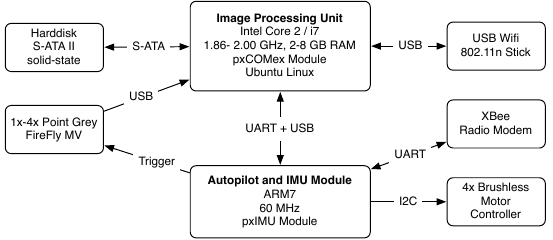
Figure 6: Onboard sensors and avionics with electronic buses. 4 MAVLINK